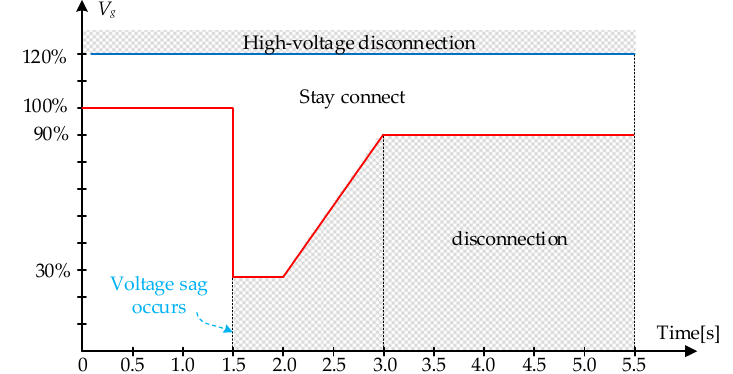
Figure 1. Requirements for low-voltage ride-through (LVRT) capability.